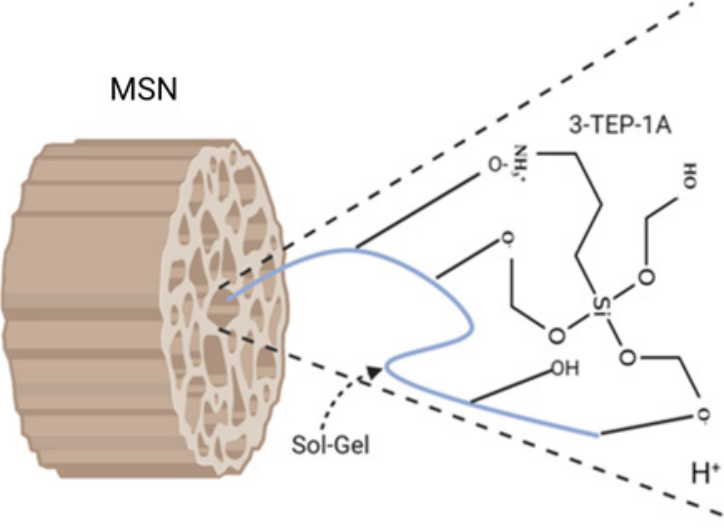
Figure 4. Schematic illustration of the sol-gel interaction pH-responsive and anchoring the 3-(triethoxysilyl) propane-1-Amine (3-TEP-1A) molecule on the inner pore surface of the modified mesoporous silica nanoparticles (MSN).